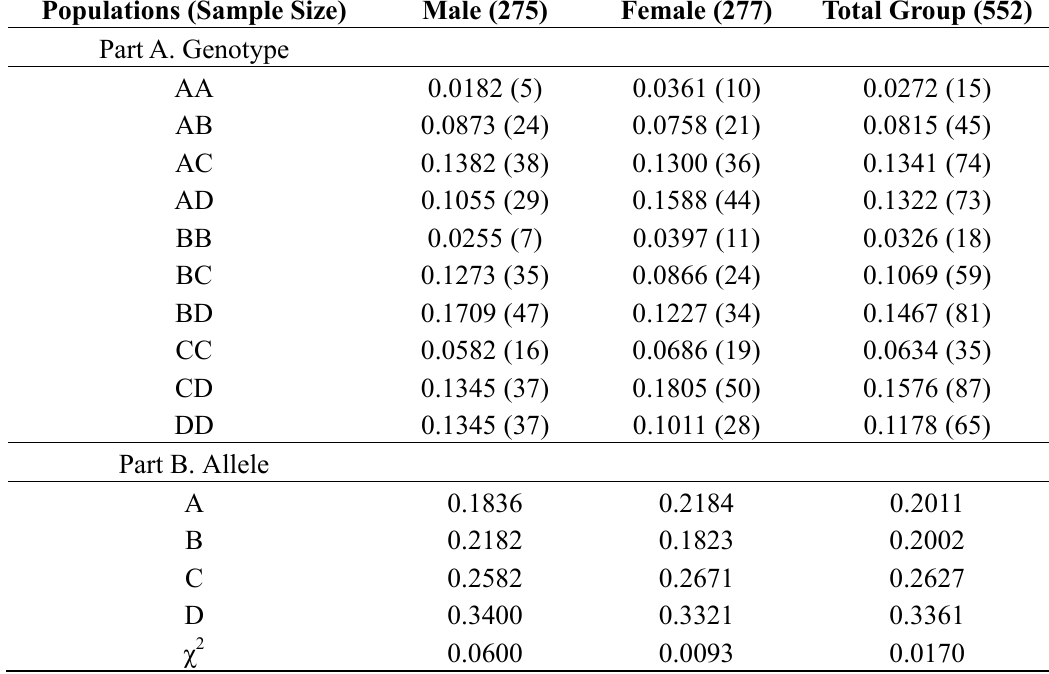
Table 1. Genotypic and allelic frequencies at the 39th and 74th bp of exon 2 of the GH gene ( n = 552). Part A, Genotypic frequencies; Part B, Allelic frequencies. Populations (Sample